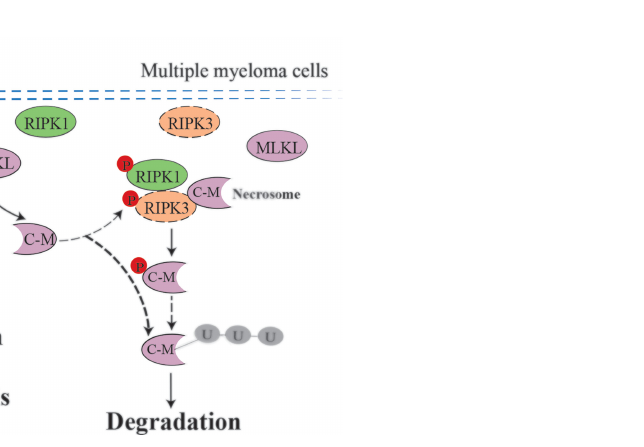
FIGURE 8 | Possible mechanism of MLKL cleavage-mediated necroptotic activation in MM cells. Cell death triggers, such as DHA, EPA and bortezomib, induce activated caspases-mediated MLKL cleavage in multiple myeloma cells, which are RIPK3-de fi cient cells. After cleavage, the N-terminal cleavage induce necroptosis by oligomerization and the C-terminal cleavage may be degraded by the ubiquitin – proteasome system. Small amounts of C-terminal cleavage can be phosphorylated by low abundant RIPK3 existing in MM cells and subsequently degraded. Dashed arrows, need to be further